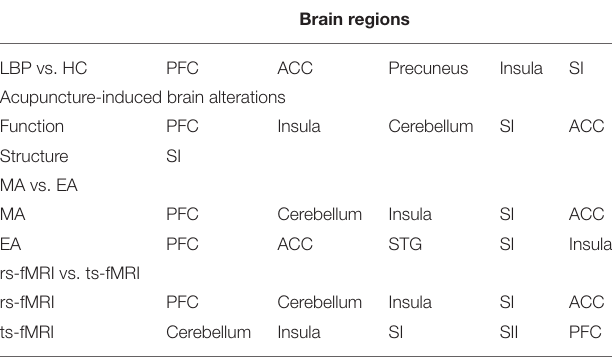
TABLE 2 | Brain imaging data of frequently reported brain